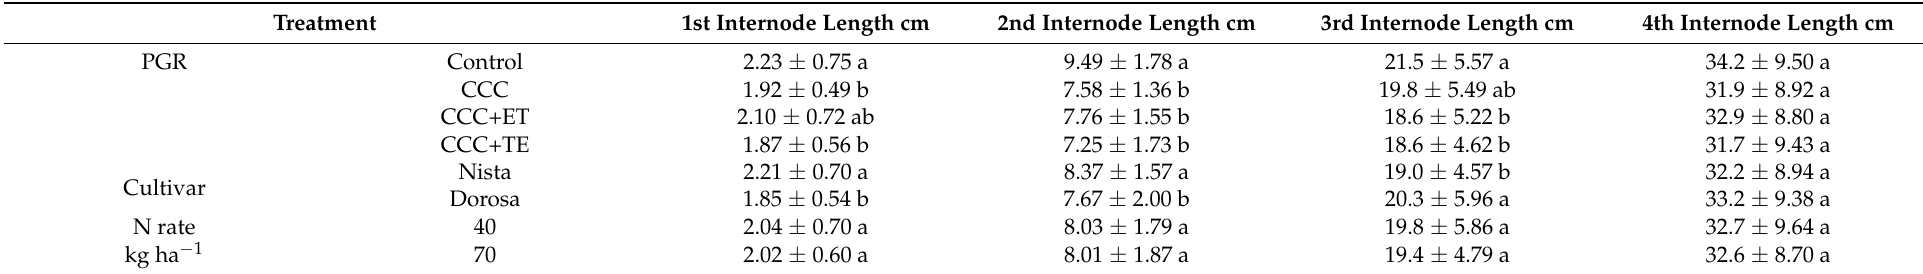
Table 3. Internode length of red fescue generative tillers ( Festuca rubra ssp. rubra cv. Nista and F . r . ssp. commutata cv. Dorosa), means for two production years, and two field